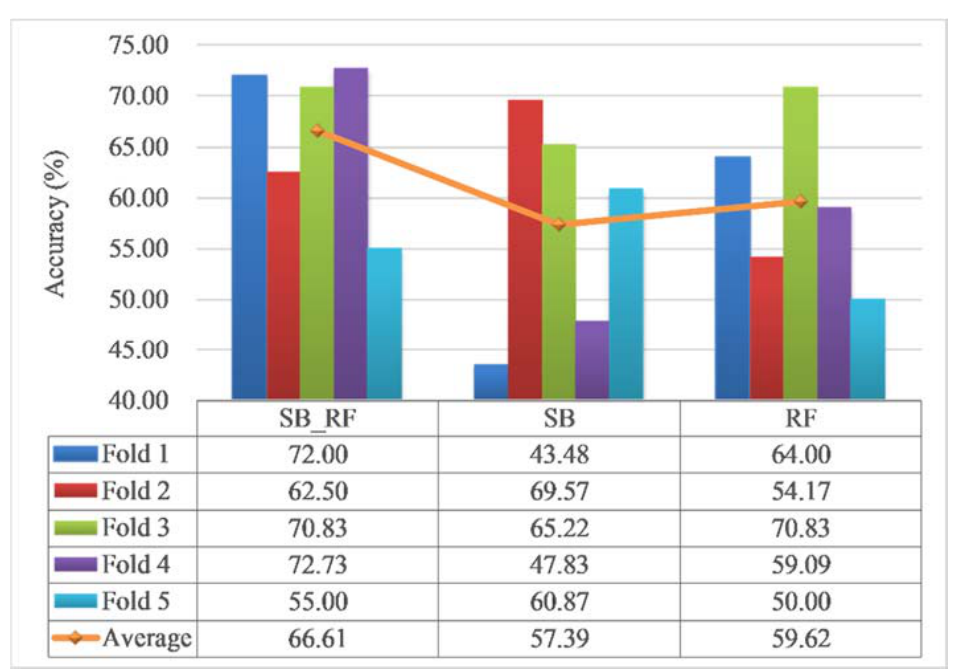
Figure 6. Model performance of the 5 ‐ fold cross ‐ validation.